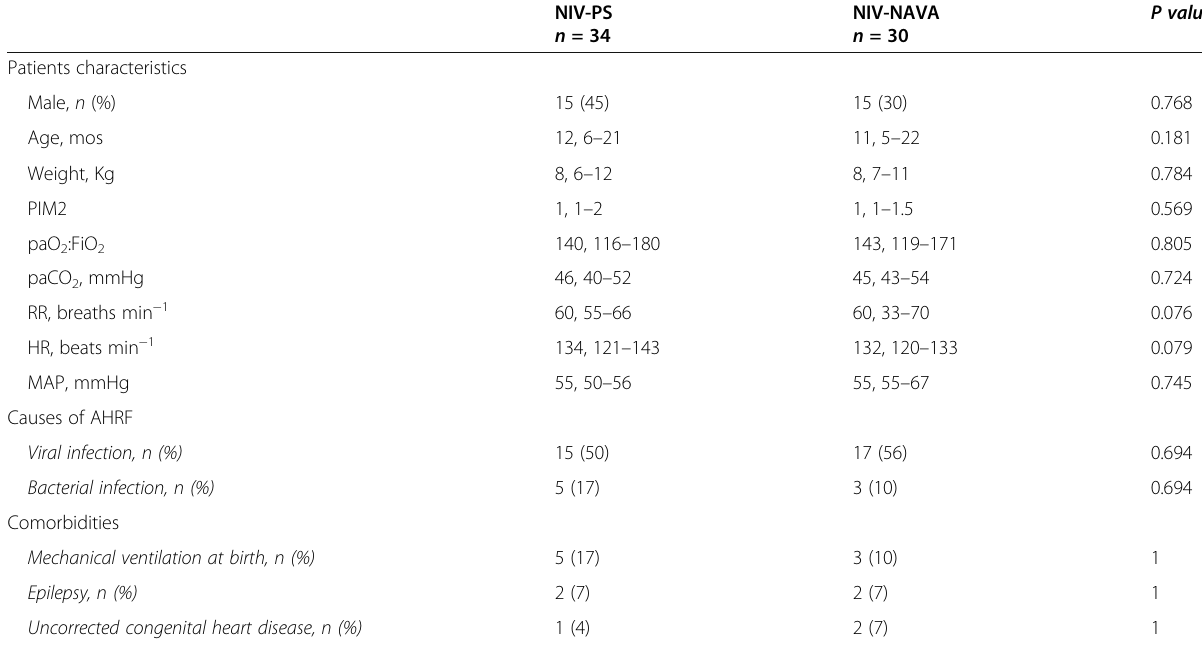
Table 1 Baseline characteristics of patients